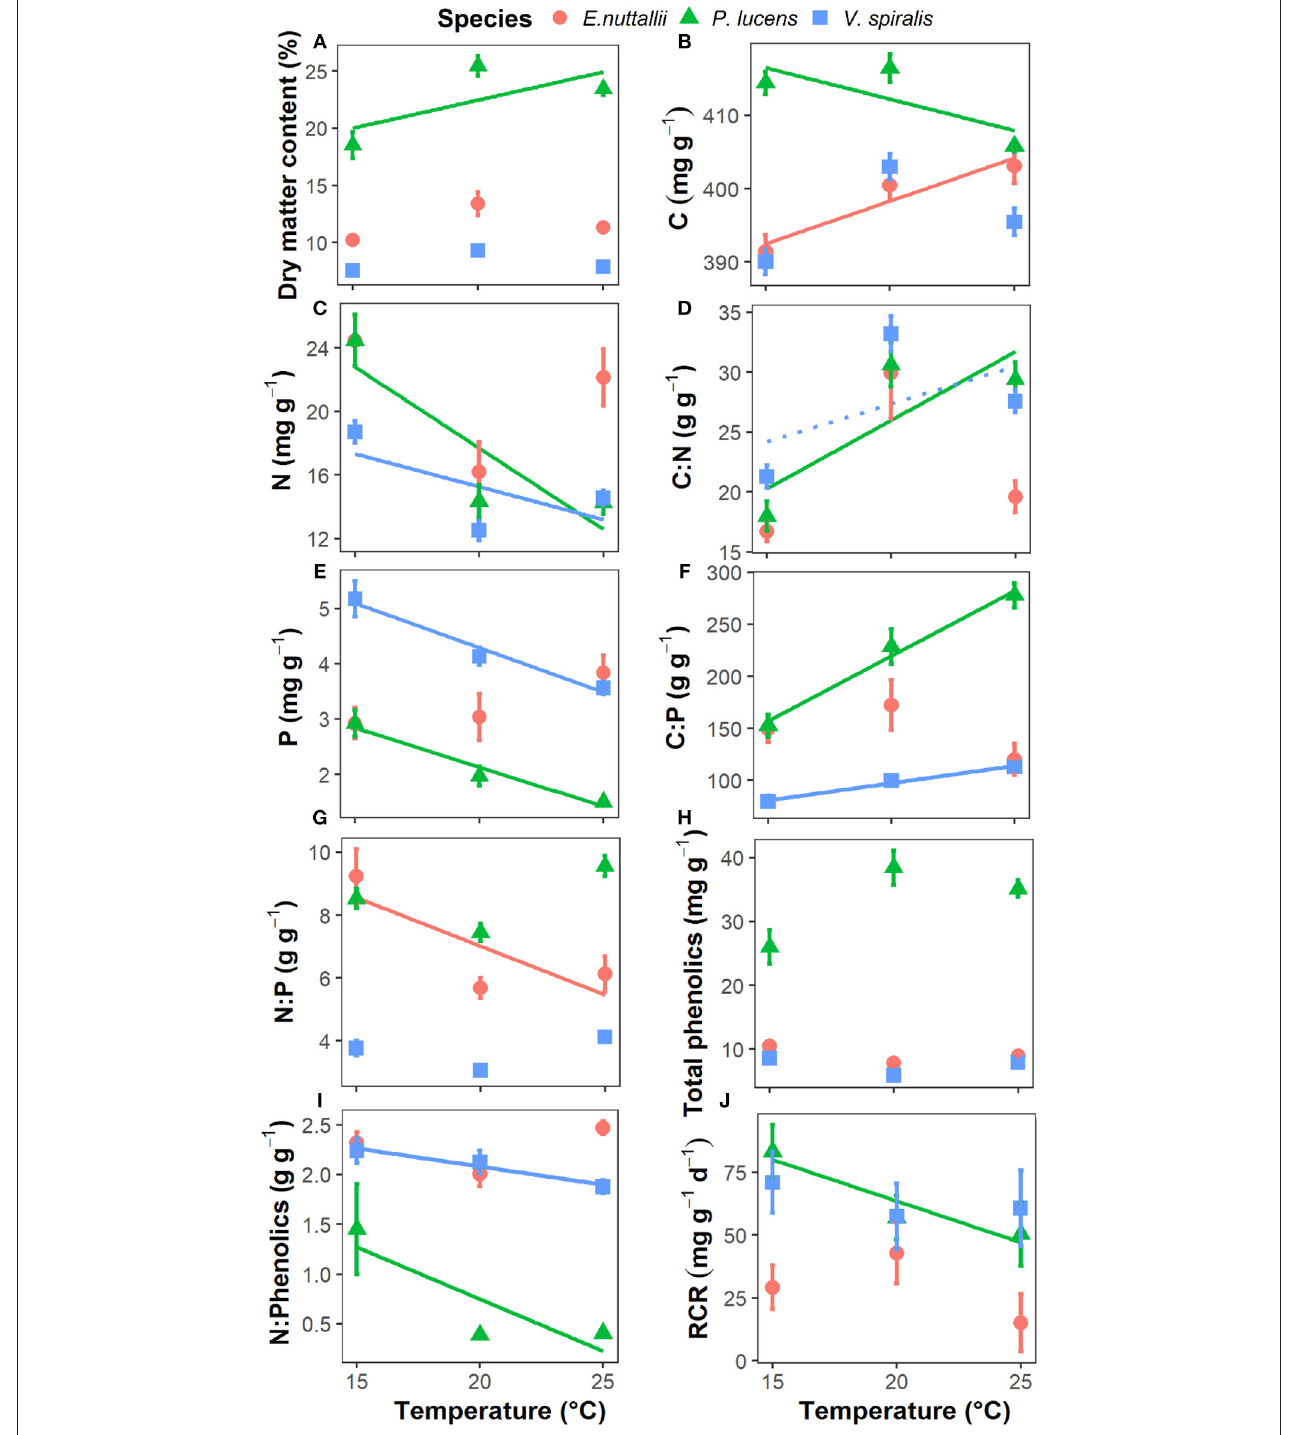
FIGURE 2 | Response of aquatic plant traits and palatability to rising temperature in the three aquatic plants. (A) plant dry matter content, (B) plant C content, (C) plant N content, (D) plant C:N ratio, (E) plant P content, (F) plant C:P ratio, (G) plant N:P ratio, (H) plant total phenolics concentration, (I) plant N:Phenolics ratio, and (J) plant palatability indicates plant relative consumption rate, RCR. Point with bar represents mean ± SE ( n = 15 for each point). Temperature effects on the parameters of each species are indicated by regression lines. A solid line indicates p < 0.05, a dotted line indicates 0.05 < p < 0.1, and without line indicates p > 0.1.